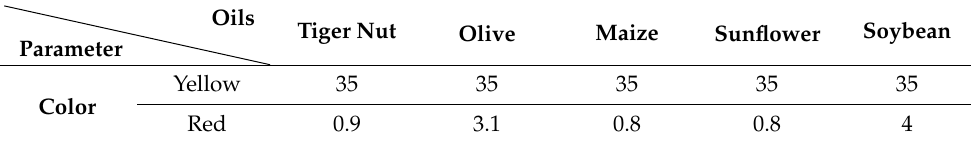
Table 10. Colors of the studied edible oils